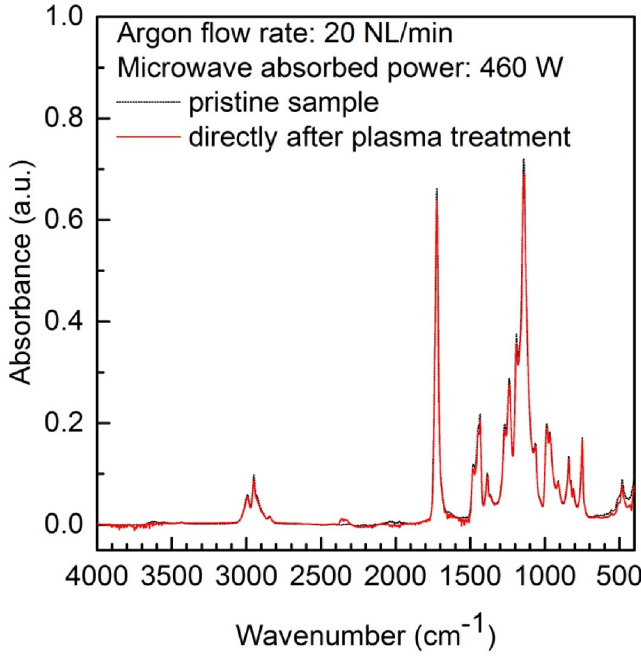
Figure 10. ATR FTIR spectra of PMMA polymer before and after plasma treatment measured in a wavenumber interval of 4000–400 cm −1 . Argon flow rate 20 NL/min. Microwave power 460 W.